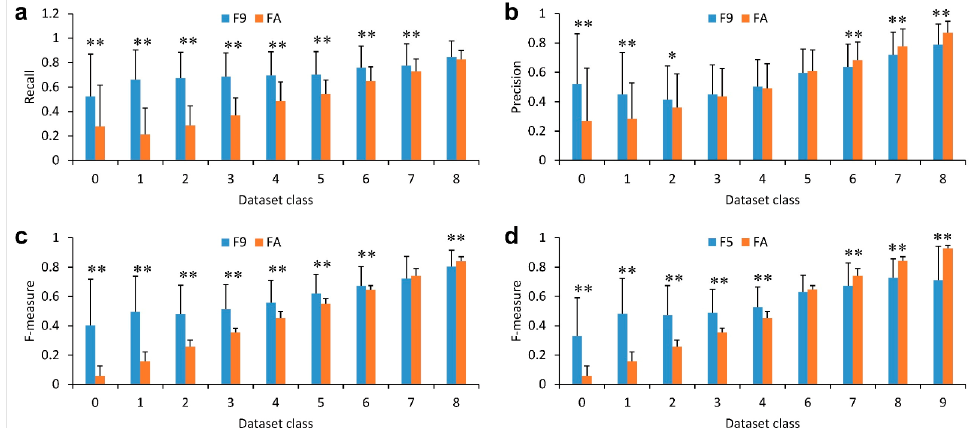
Figure 5. Evaluation of the AI model trained using images with the same class of F-measure values. The output image by AI model F9 was compared with the target by calculating the values of ( a ) recall, ( b ) precision, and ( c ) F-measure; ( d ) F-measure values of output images by AI model F5. Mean ± S.D., n = 200, ** p < 0.01, * p <